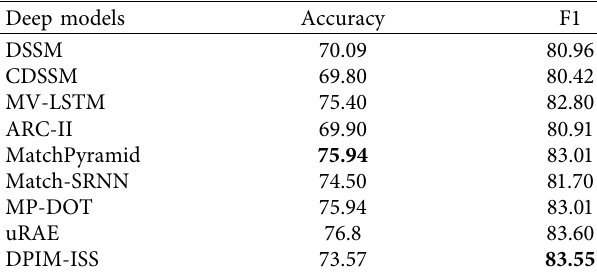
Table 4: Comparison with other deep models for paraphrase identification on the MSRP dataset.